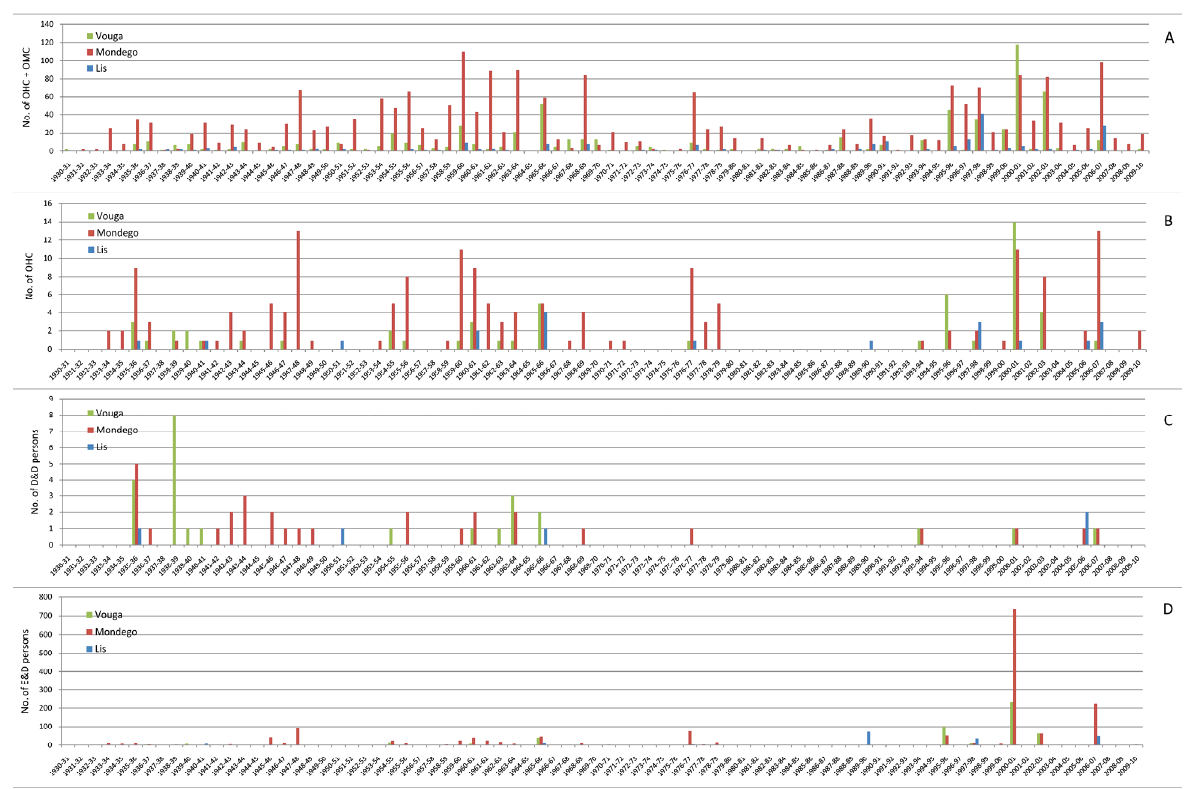
Figure 1. Inter-annual distribution of total occurrences ( A ); number of OHC ( B ); number of D & D persons ( C ); and number of E & D persons ( D